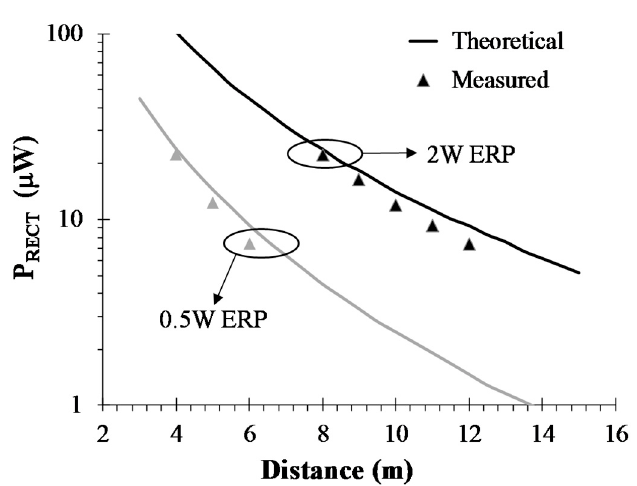
Figure 5. Measured and simulated rectified power for different link distances.